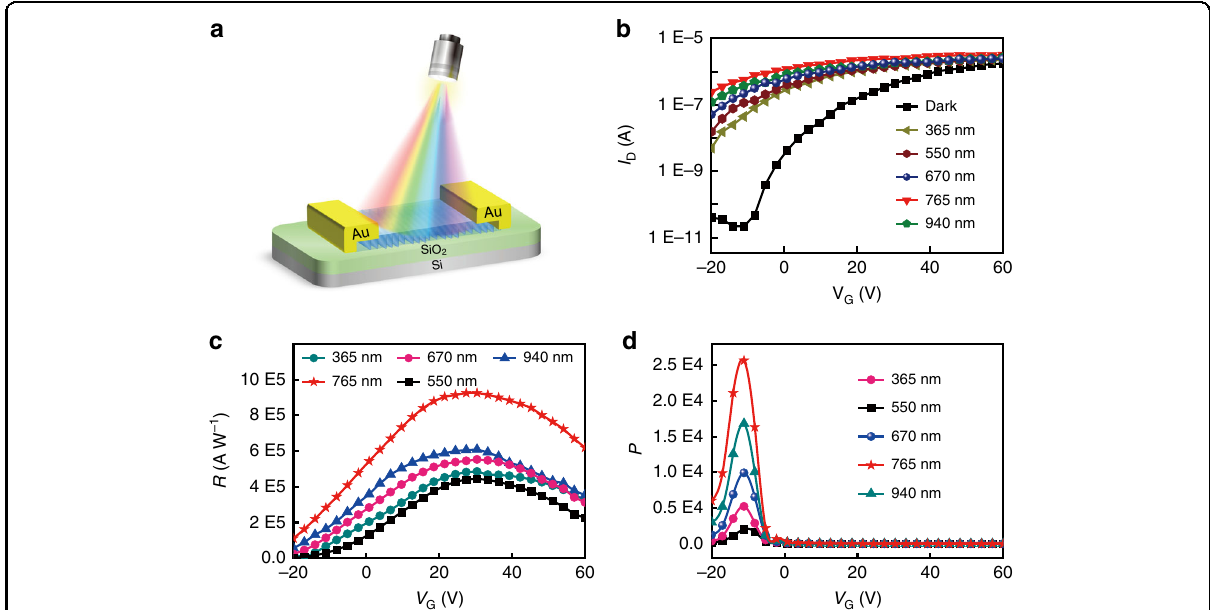
Fig. 4 The phototransistor based on the self-assembled TDPPQ nanosheet. a The schematic illustration of the TDPPQ-nanosheet-based phototransistor. b Photocurrent responses of the TDPPQ-nanosheet-based phototransistor under the illumination of different monochromatic light (365nm, 550 nm, 670 nm, 765 nm, and 940 nm) with a fi xed light intensity of 600 μ W cm − 2 . c Photoresponsivity and d photosensitivity of a representative device under the illumination of different monochromatic light (365nm, 550 nm, 670 nm, 765 nm, and 940 nm) with a fi xed light intensity of 600 μ W cm −